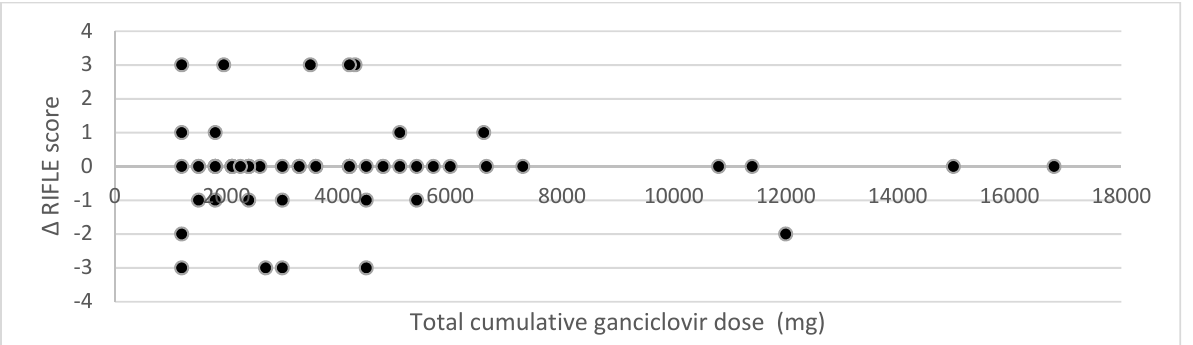
Figure 2. Impact of cumulative ganciclovir dose on the change in serum creatinine.